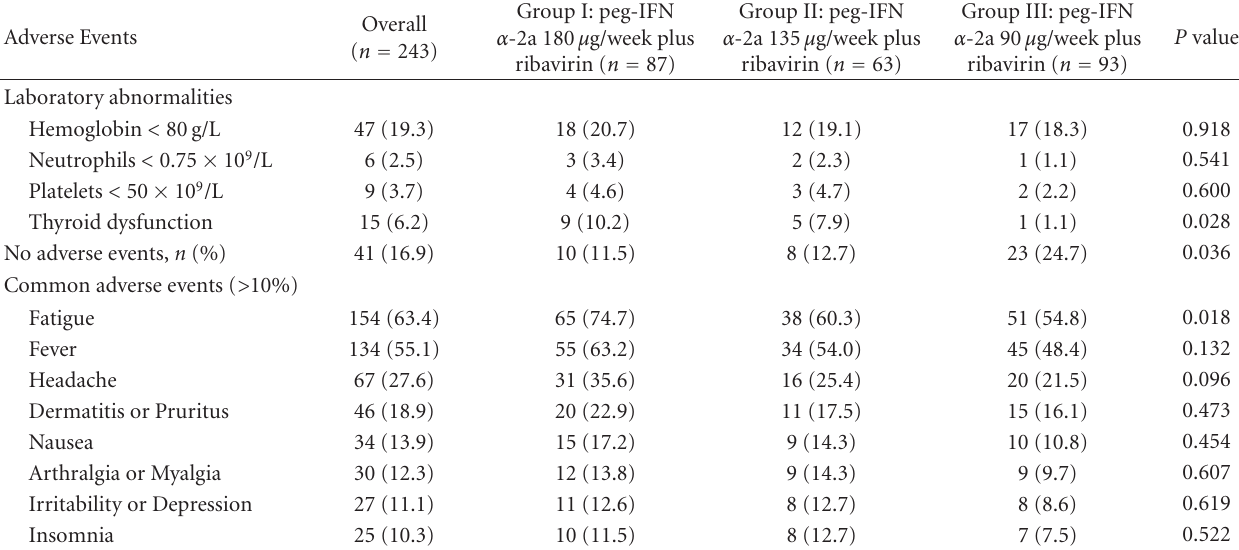
Table 4: Adverse clinical and laboratory reported during treatment and